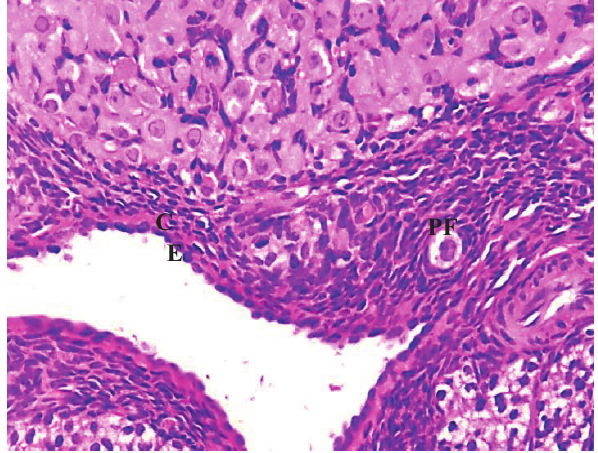
Fig-1: Photomicrograph of ovary of albino rat showing normal simple cuboidal Epithelium (E), Capsule (C), Primordial Follicle (PF). (H & E, 40X)